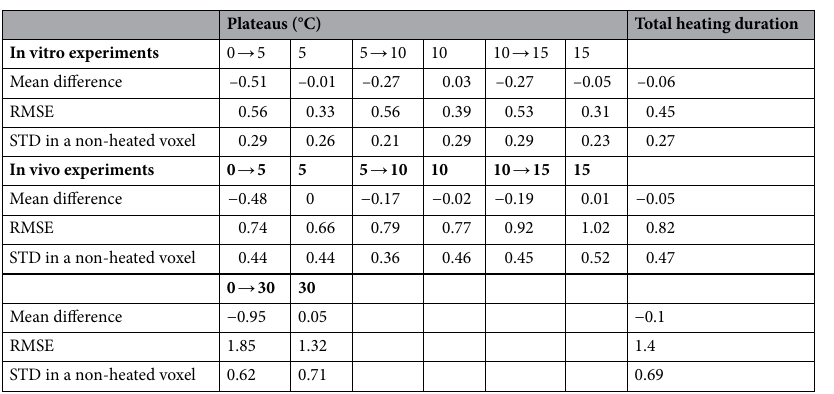
Table 1. Summary of the regulation performance for in vitro and in vivo experiments. The mean differences between target and experimental temperature, together with RMSE at the control voxel are reported for each plateau of temperature increase and the total heating duration. The standard deviation of temperature (STD) in a non-heated voxel is also indicated to illustrate the stability of the thermometry method.